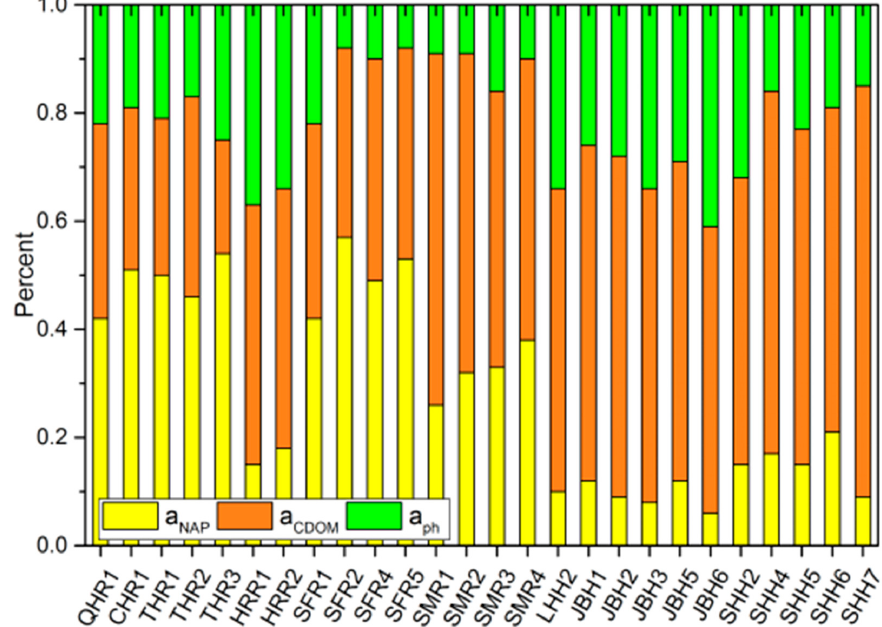
Figure 4. Relative contribution of phytoplankton (a ph ), NAP (a NAP ) and CDOM (a CDOM ) to the total absorption of the sample points with relative errors (RE) greater than 0.6 (based on LOO-CV analysis). Sample points are represented on the x-axis with the abbreviations of the location’s name.